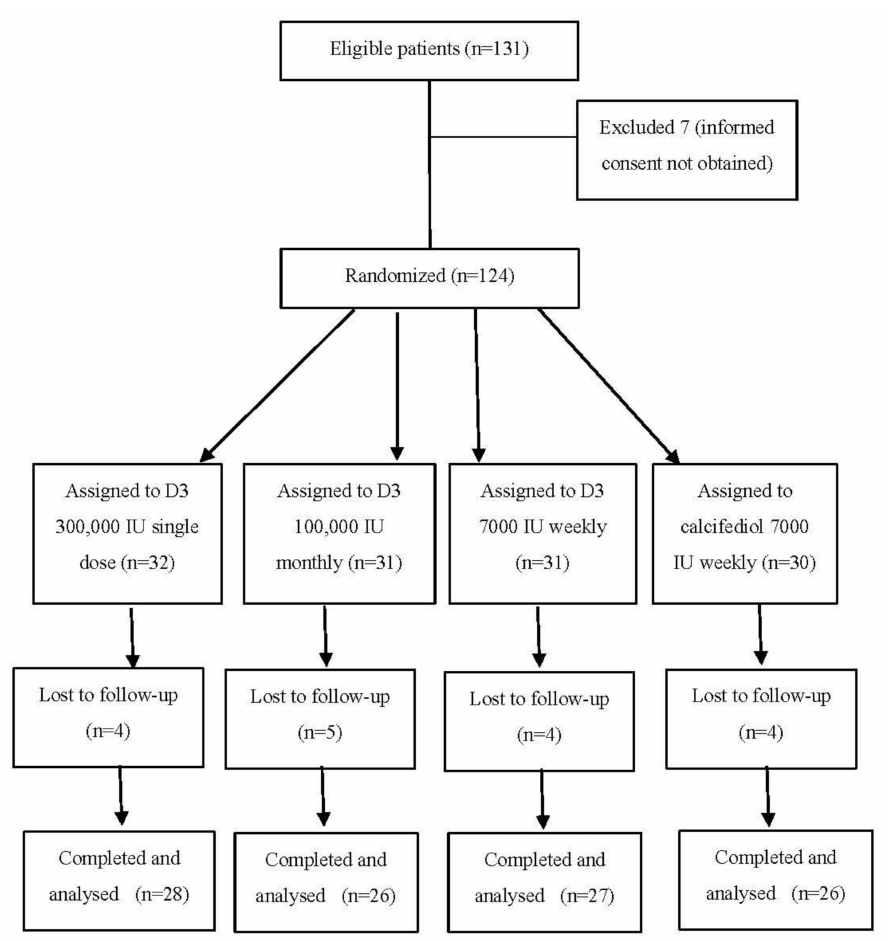
Figure 1. Flowchart of study population. At baseline, patients randomly assigned to receive the different Vitamin D supplemen- tation schemes with cholecalciferol and calcifediol showed no differences with respect to BMI, age, sex, and serum levels of 25(OH)D 3 , 1,25(OH)D 3 , calcium, phosphorus. Patients of Group 2 showed a greater serum level of PTH compared to other treatment groups ( p < 0.05); patients of Groups 3 and 4 showed higher serum levels of alkaline phosphatase (ALP) compared to Groups 1 and 2 ( p < 0.05). In all groups, both PTH and ALP levels were within normal limits. No differences in tests for measurement of lower extremity muscular function were observed at baseline between the different treatment groups. Data are shown in Table